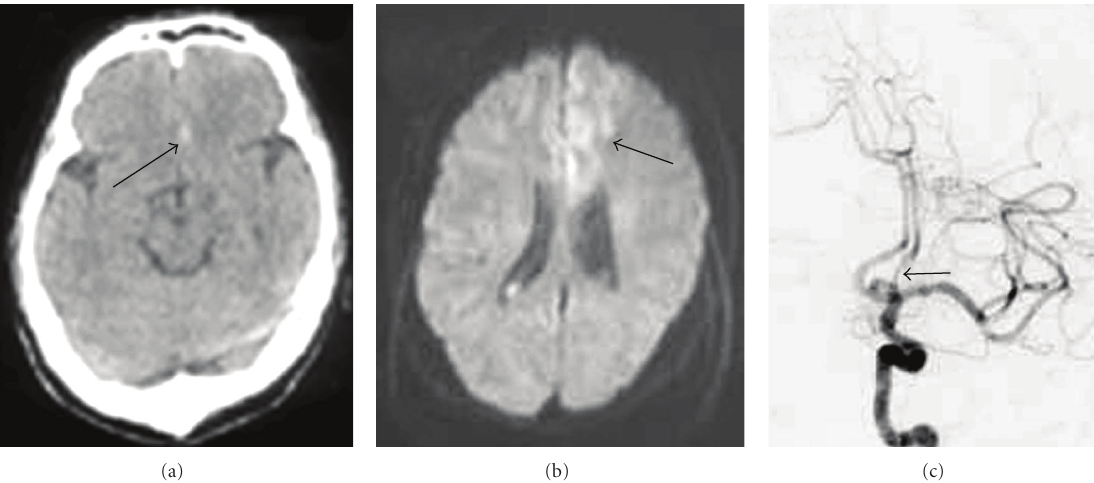
Figure 1: Imaging findings on the day of onset. (a) Computed tomography shows very thin subarachnoid hemorrhage on the left side of the interhemispheric fissure (arrow). (b) Magnetic resonance imaging (di ff usion image) reveals infarction of the left medial frontal region (arrow). (c) Left internal cerebral artery angiography reveals stenosis (string sign) of the A 2 segment (arrow).